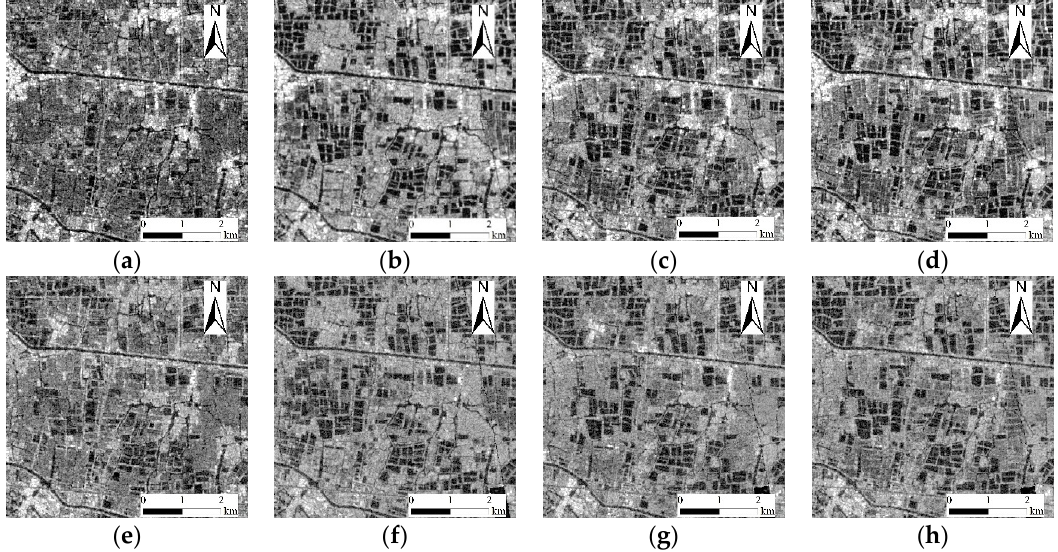
Figure 4. Sentinel-1 C-SAR vertical transmitted and vertical received (VV) images in the study area on the first ten days of May ( a ), July ( b ), August ( c ), October ( d ), 2017, and VH images on the first ten days of the May ( e ), July ( f ), August ( g ) and October ( h ), 2017.